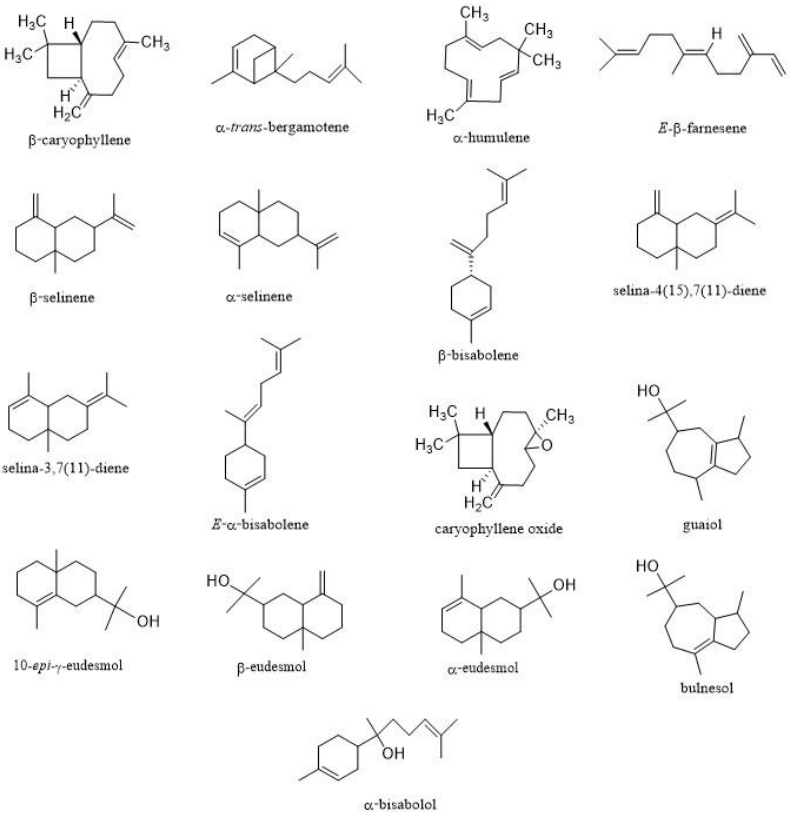
Figure 1. Chemical structures of the main sesquiterpenes found in the 9 EOs.